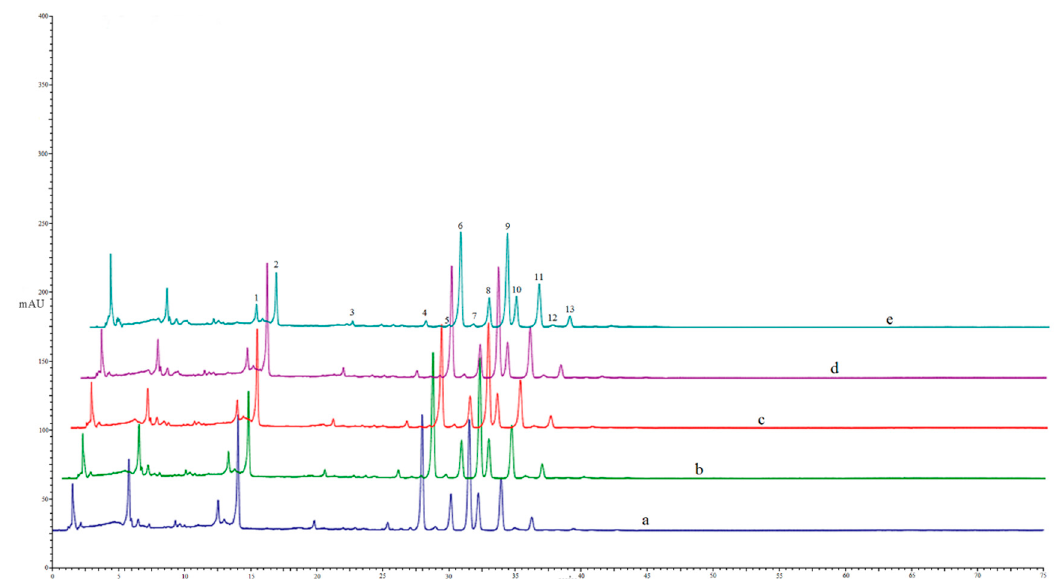
Figure 1. HPLC profiles of extracts from the navel orange peels dried by different drying methods. The letters from a to e, represent FD, SD, OD50, OD70, and MD, respectively. The number above the peak represent the following compounds: (1) narirutin, (2) hesperidin, (3) didymin, (4) iso- sinensetin, (5) 3,3 ′ ,4 ′ ,5,7,8-hexamethoxyflavone, (6) sinensetin, (7) 4 ′ ,5,7,8-tetramethoxyflavone, (8) 3,3 ′ ,4 ′ ,5,6,7-hexamethoxyflavone, (9) nobiletin, (10) 4 ′ ,5,6,7-tetramethoxyflavone, (11) 3,3’,4’,5,6,7,8- Table 2. HPLC quantification analysis of flavonoids ( μ g/mg DW) in extracts from the orange peels dried by different methods.